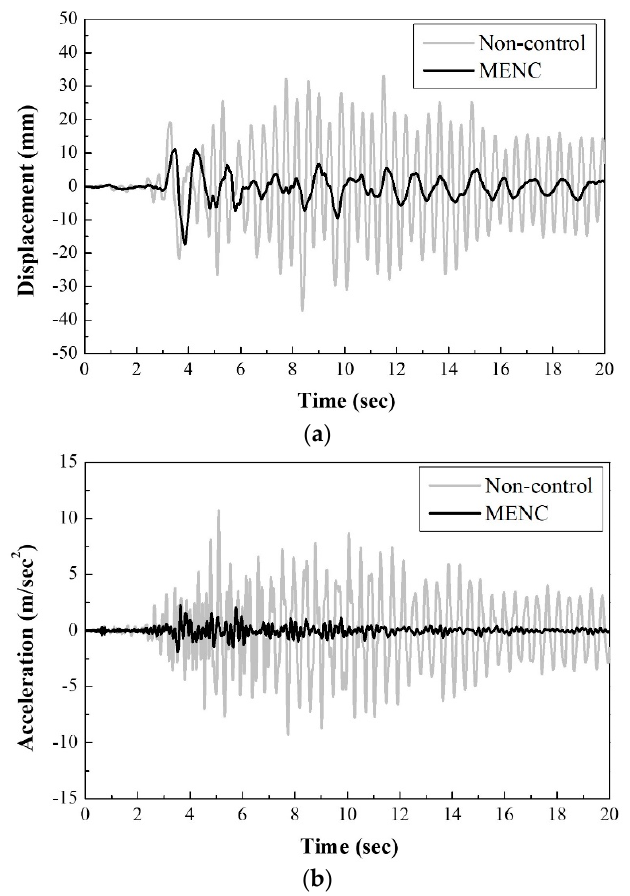
Figure 9. Comparison of control and non-control responses of the building structure under the Northridge earthquake: ( a ) displacement; ( b ) acceleration. The decreasing rate of the maximum responses on the seismic loads is also shown in Table 3. The decreasing rates of the maximum displacement and acceleration on the third floor were 78.12% and 88.48%, respectively. Therefore, it was found that the proposed MENC algorithm could significantly reduce the structural response under unknown seismic load if applied to the AMD